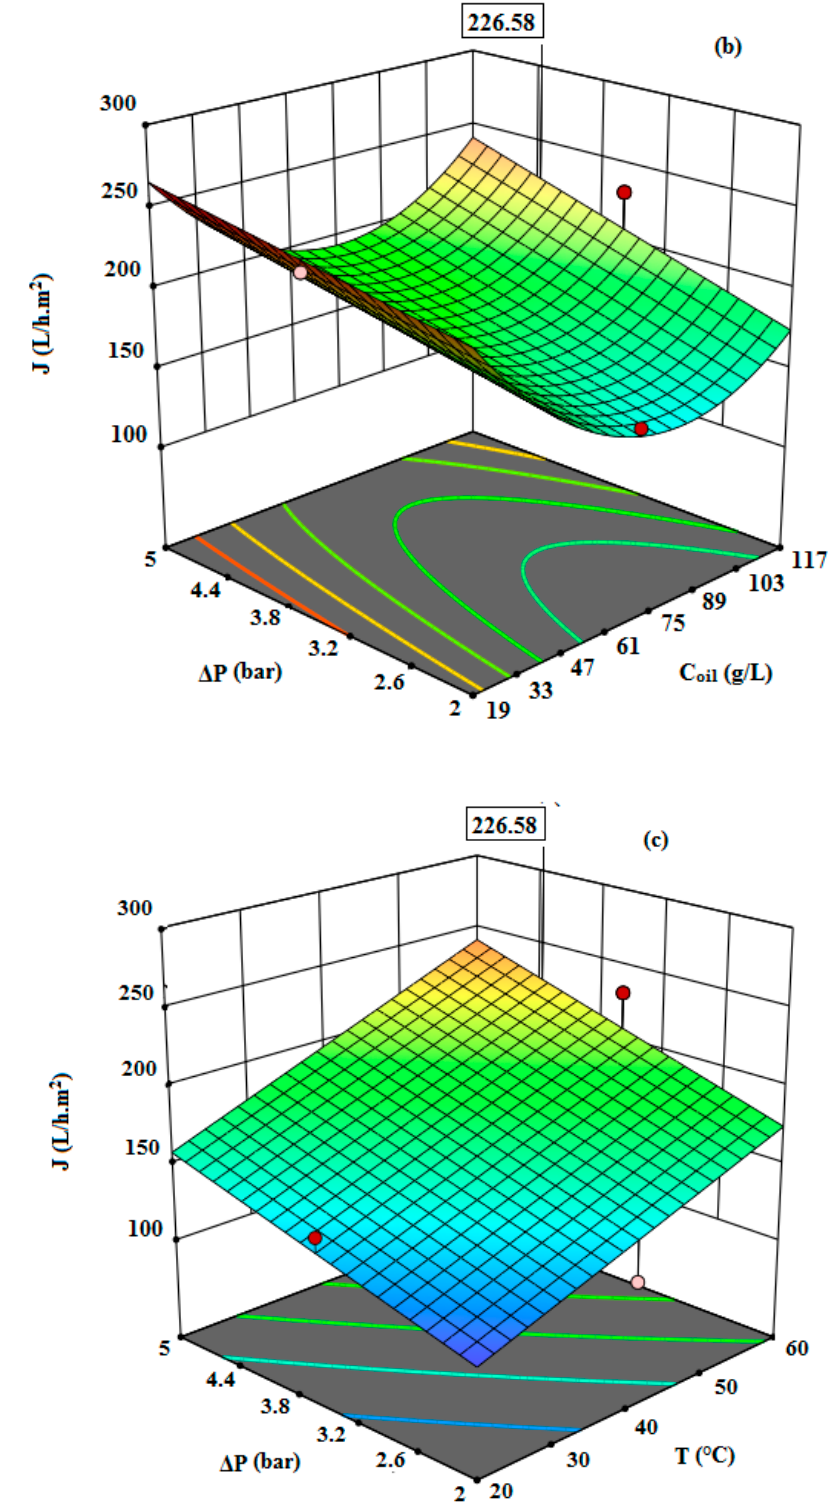
Figure 7. The response surface plots showing the effects of variables on permeate flux: The interac- tion of initial oil concentration and temperature ( a ), the interaction of initial oil concentration and transmembrane pressure ( b ), the interaction of temperature and transmembrane pressure ( c ).